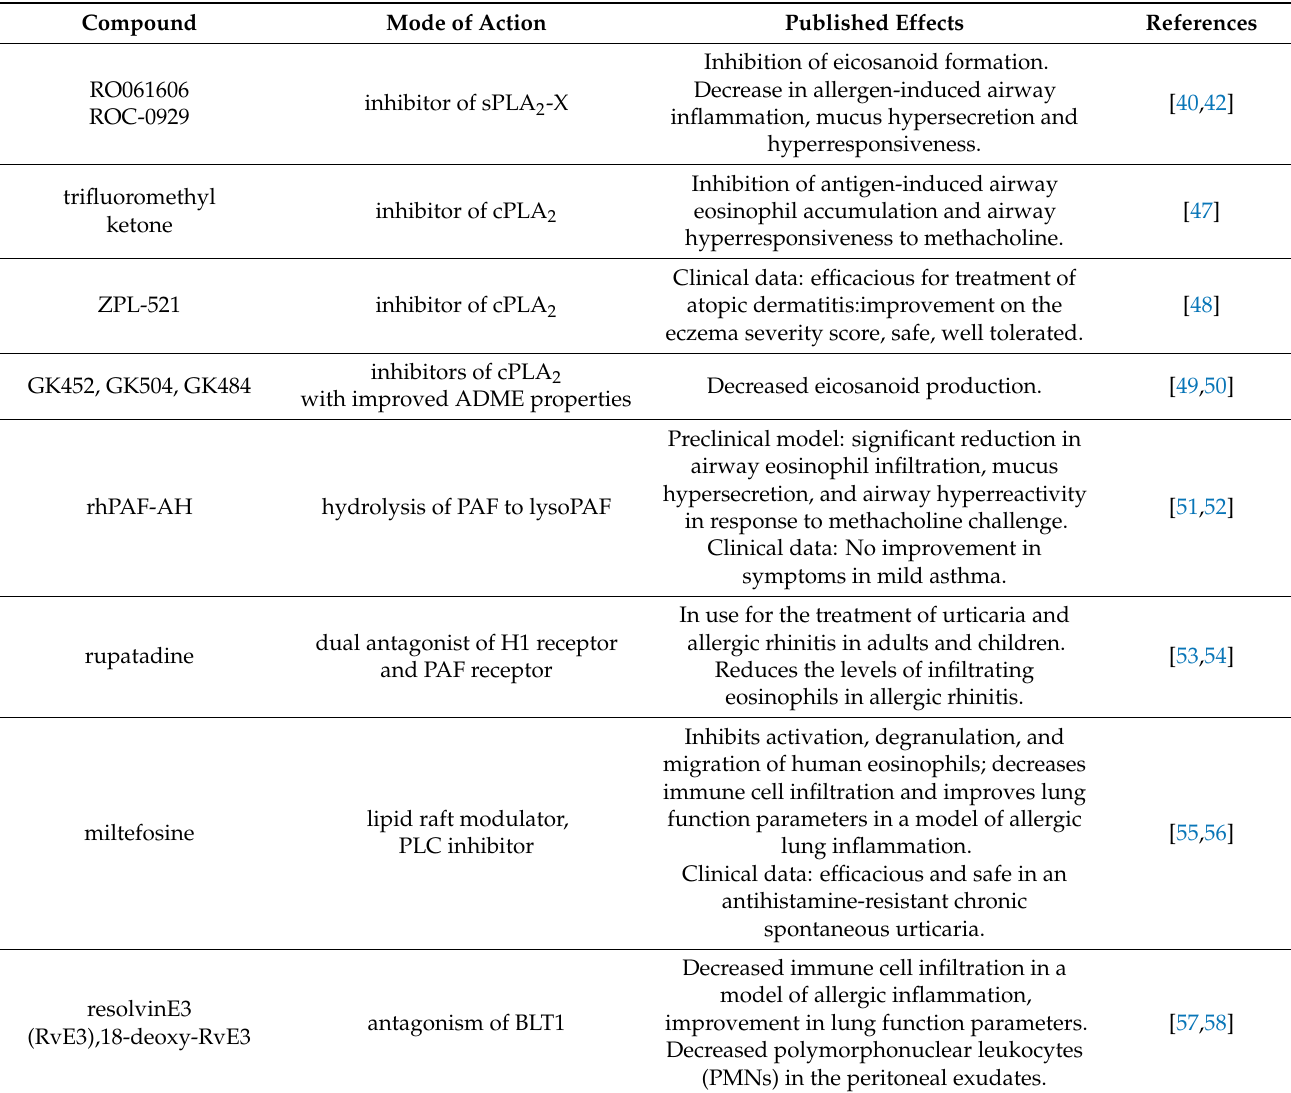
Table 1. Novel therapeutic options targeting lipid mediators with potential for targeting eosinophilic over-activation.